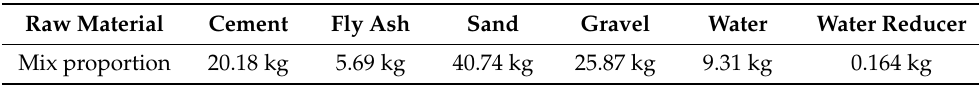
Table 2. Mix proportion of SCC.